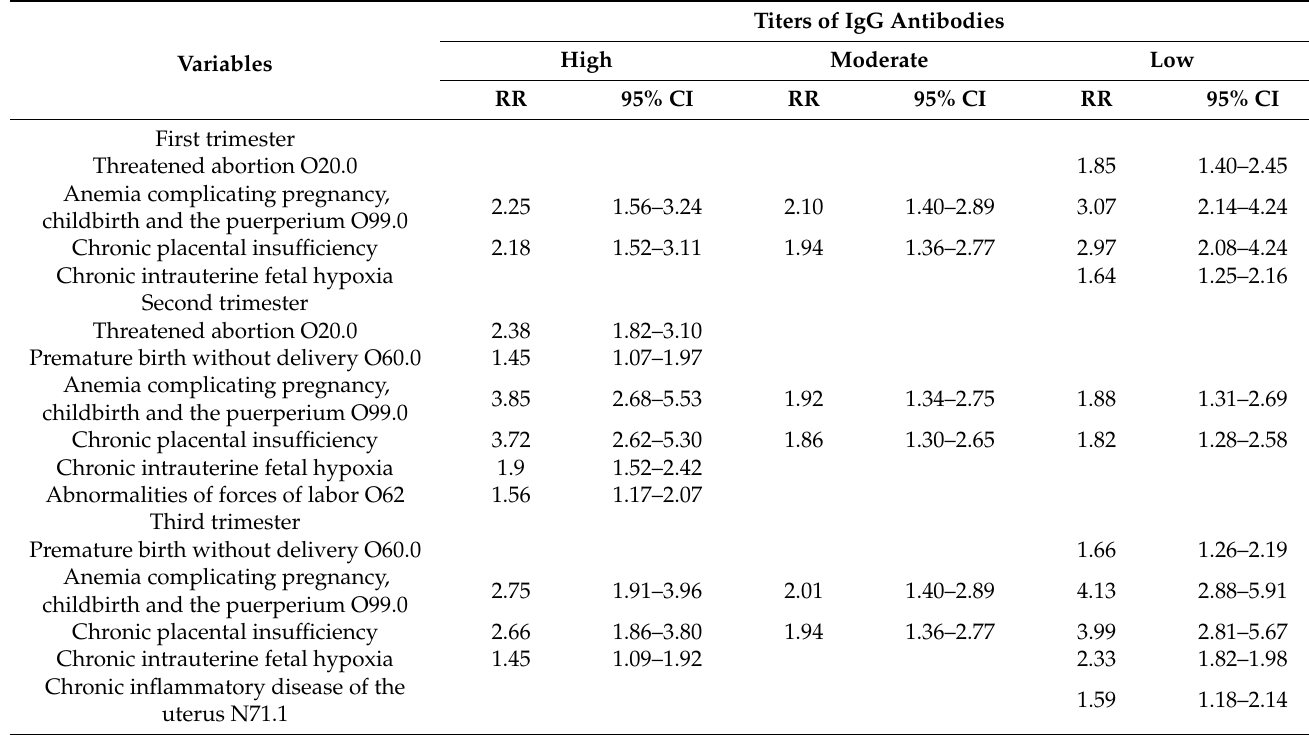
Table 11. Risk factors for the development of complications of pregnancy, childbirth and the early postpartum period, depending on the titers of IgG antibodies in women with recurrent HSV-1 during